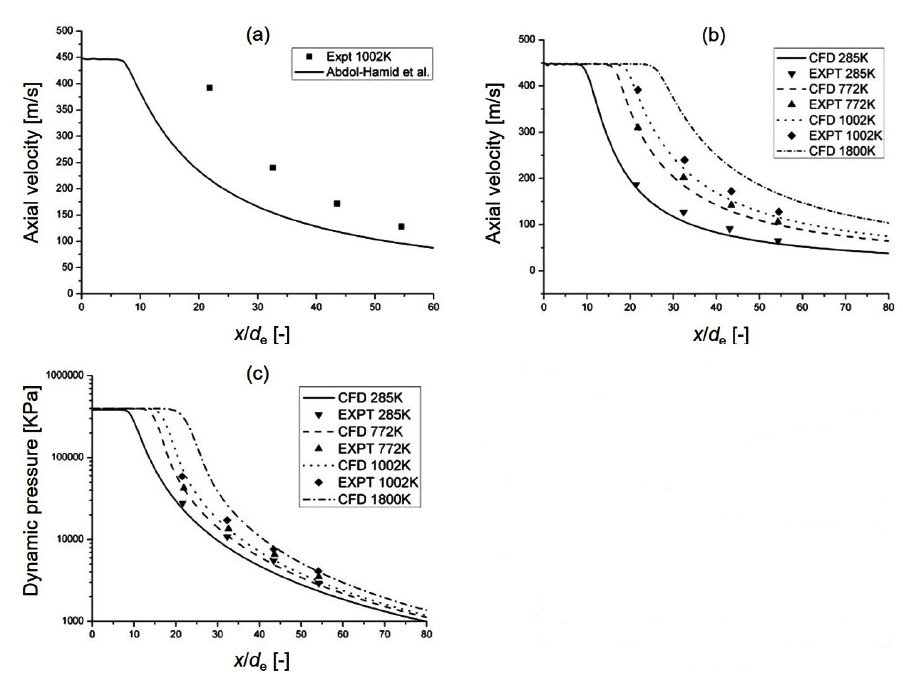
Figure 9. ( a ) and ( b ) Axial velocity distribution, ( c ) dynamic pressure distribution along the central axis of the jet ( x : distance along the central axis, de : nozzle diameter) [243].